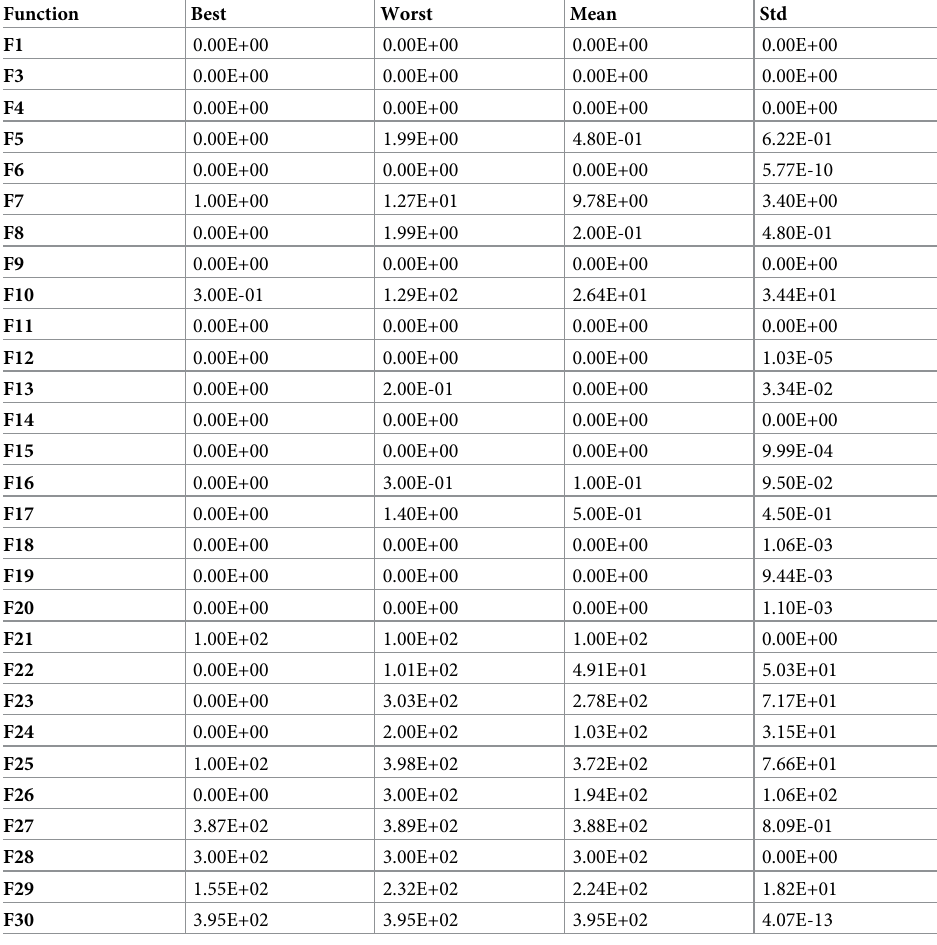
Table 6. Results for ADMO in 10